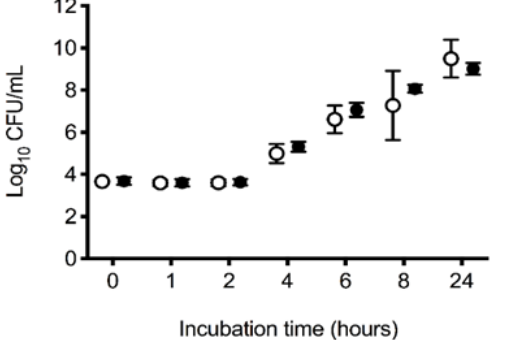
Figure 4. In vitro 24 h log 10 growth of Escherichia coli ATCC 25922 in serum. Mean (95% CI) in vitro 24 h log 10 growth (colony forming units; CFUs) of Escherichia coli ATCC 25922 in serum removed from dogs at the completion of a 6 h experiment. Between baseline and the second hour of the 6 h experiment, all dogs had 900 mL of whole blood removed, had 15 mL/kg of allogenic, stored, packed red blood cells transfused over 20 min, and then received 20 mL of saline (control: ○ , n = 10) or an equal volume of 13.3 mg/kg deferoxamine in saline (treatment: ● , n = 10) as a continuous intravenous infusion lasting 55 min.